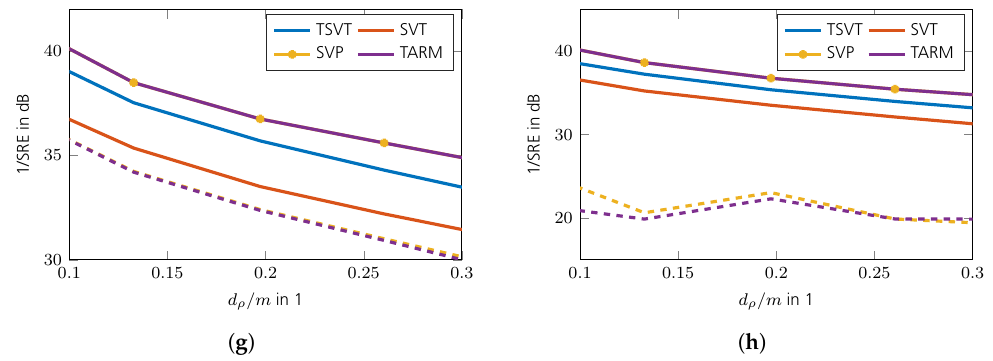
Figure 13. Comparison of SRE vs. SNR for m / n = 0.8. The solid line for SVP and TARM show R = ρ and the dashed line R = 2 ρ . ( a ) Random sensing operators A ∼ CN ( 0,1 ) for SNR = 0dB. ( b ) DFT sensing operator for SNR = 0dB. ( c ) Random sensing operators A ∼ CN ( 0,1 ) for SNR = 10dB. ( d ) DFT sensing operator for SNR = 10dB. ( e ) Random sensing operators A ∼ CN ( 0,1 ) for SNR = 20dB. ( f ) DFT sensing operator for SNR = 20dB. ( g ) Random sensing operators A ∼ CN ( 0,1 ) for SNR = 30dB. ( h ) DFT sensing operator for SNR =